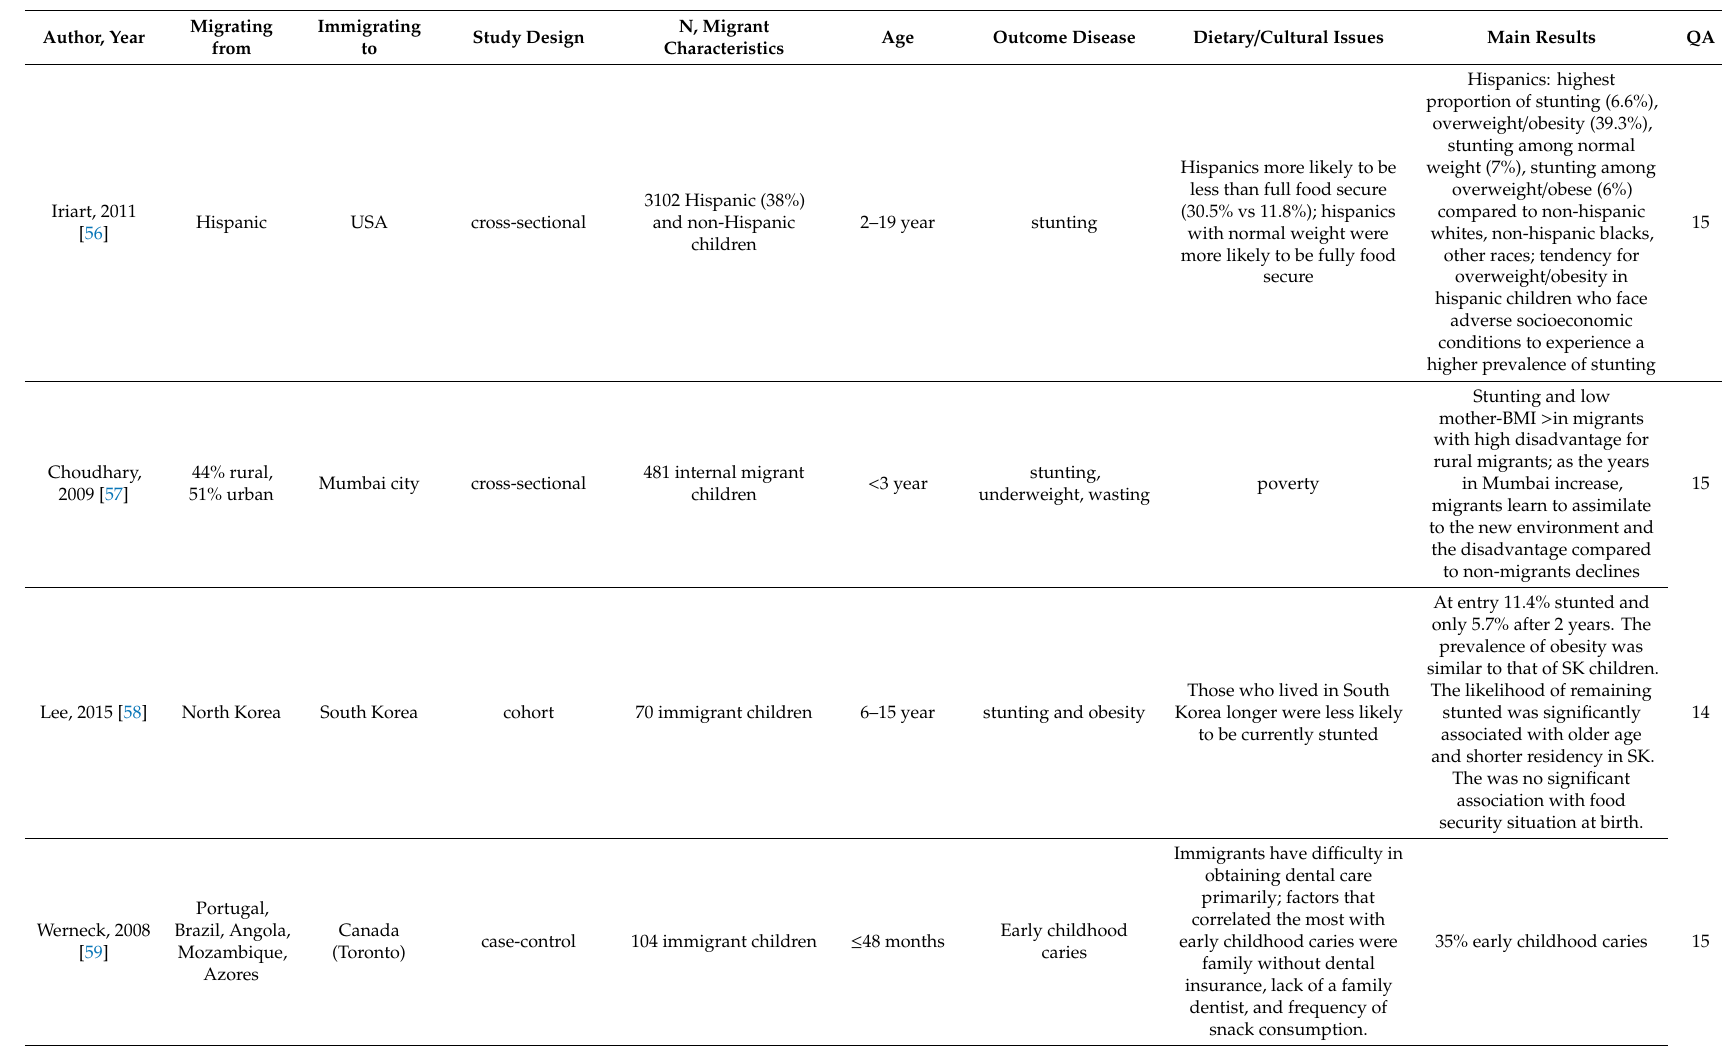
Table 6. Characteristics and main results of the included studies.